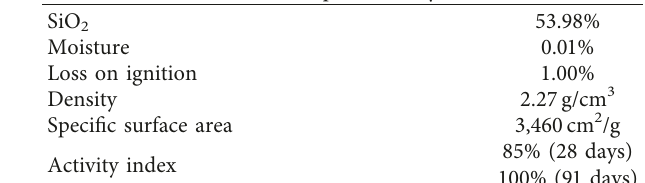
Table 2: Properties of cement and aggregates. Table 3: Properties of fly ash.